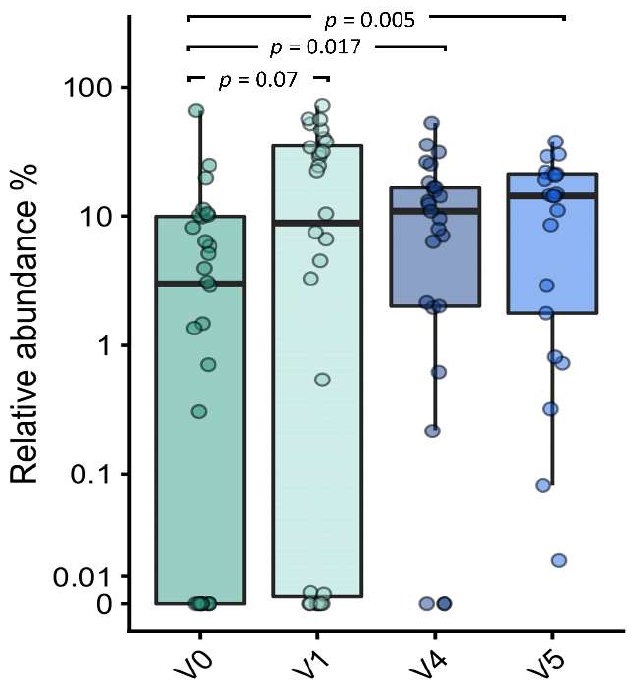
Figure 7. Boxplot of HMO-utilizing bifidobacteria at the baseline (V0) and follow-up visits at 1 month (V1), 4 months (V4), and 12 months of age (V5). Changes in relative abundance were assessed by the Wilcoxon signed rank test, comparing the baseline (V0) to subsequent visits.